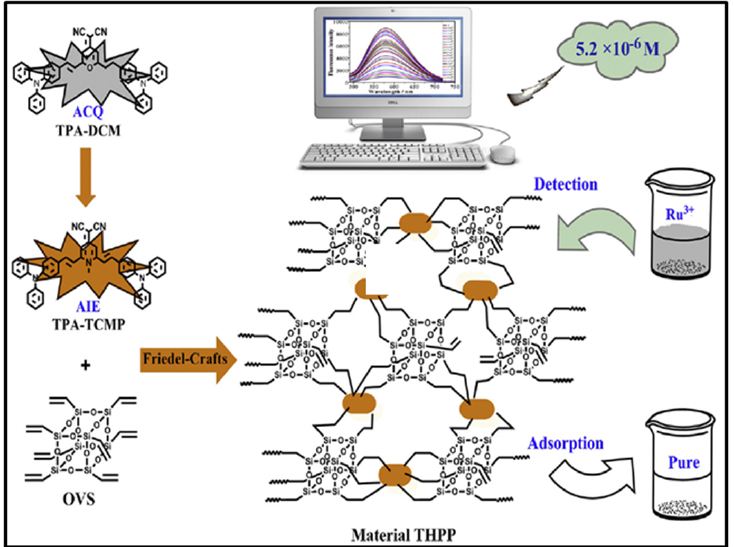
Figure 18. Synthesis of THPP and its application for concurrent detection and adsorption of Ru 3+ [97].